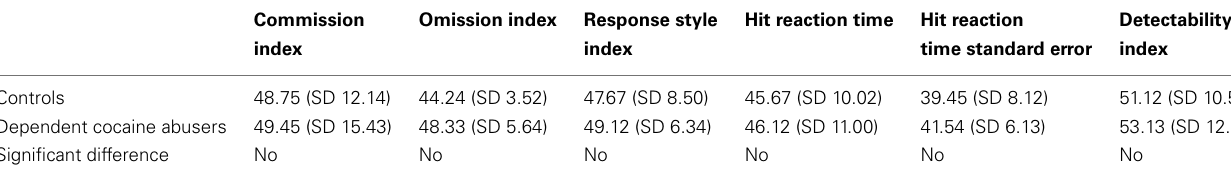
Table 2 | Conners’ continuous performance test-second edition (CPT-II) .